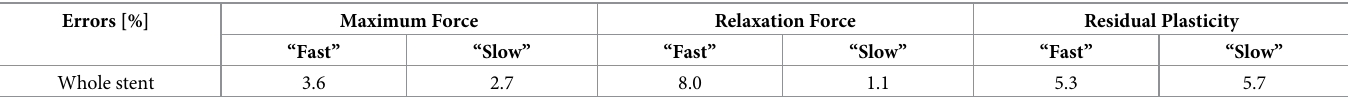
Table 5. Percentage errors obtained comparing the experimental data with the computational results obtained with the calibration phase performed on the whole free-expanded stent. Errors [%]